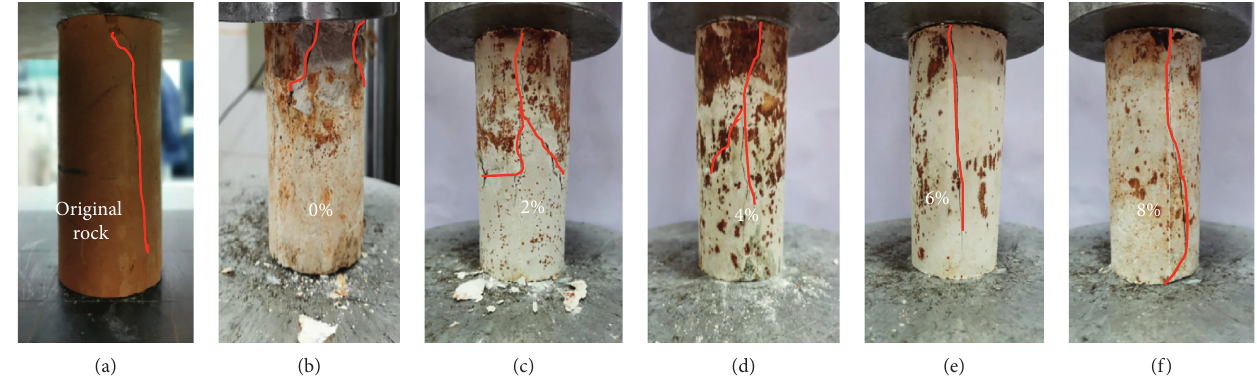
Figure 7: Shear failure patterns of similar material samples with different NBe contents (water content are controlled at 10% to 12%).